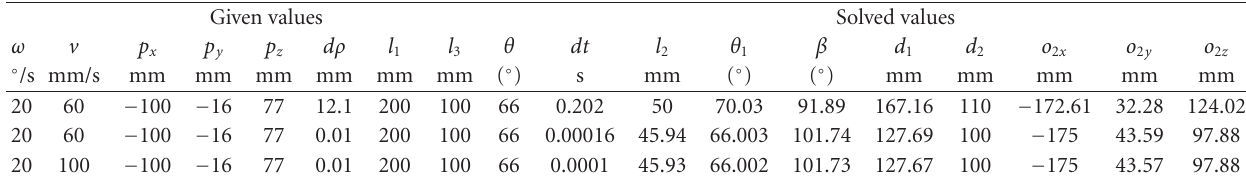
Table 3: The solved results of a spatial four-bar linkage mechanism with one-DoF. Given values Solved values ω